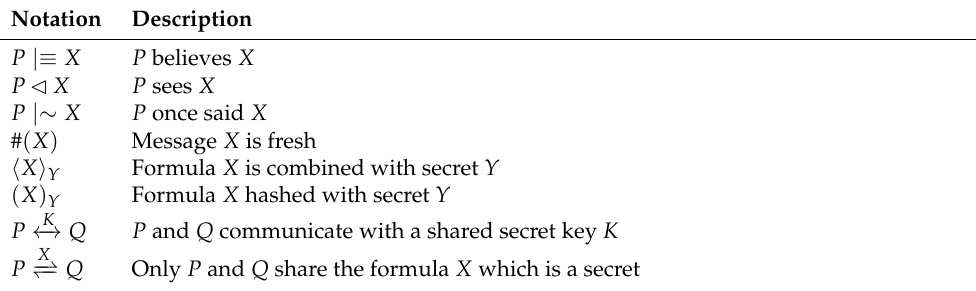
Table 2. BAN logic notations and descriptions.